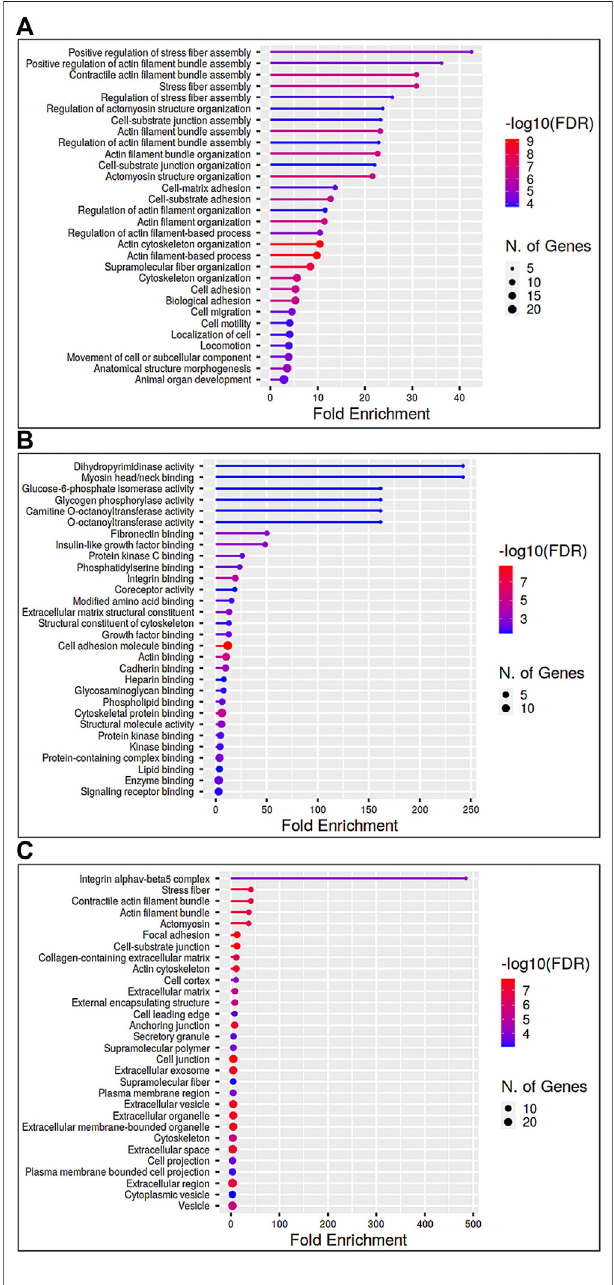
FIGURE 2 | Gene Ontology enrichment analysis of proteins elevated in the nuclear protein fraction of Dex treated (for 7 days) human TM cells. Panels (A – C) depict Gene Ontology (GO) enrichmentanalysesfor biological process, molecular function, and cellular components, respectively (using ShinyGO v0.75 online), of proteins exhibiting a ≥ 2-fold increase in three or moresamplesofTMcellstreatedfor7 dayswithDex.Analysiswasperformed using a P-value cutoff (FDR) of 0.05, and results are shown for the top 30 pathways identi fi ed via GO analysis.